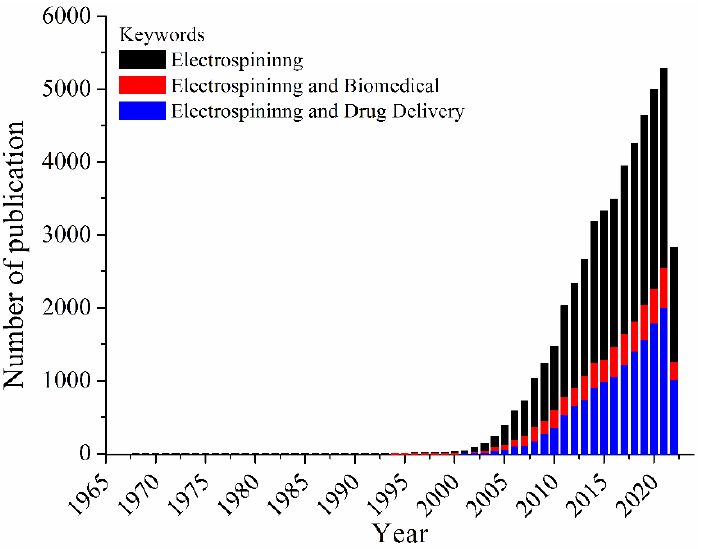
Figure 1. Number of documents per year, considering the keywords: electrospinning, electrospinning and biomedical or electrospinning and drug delivery.